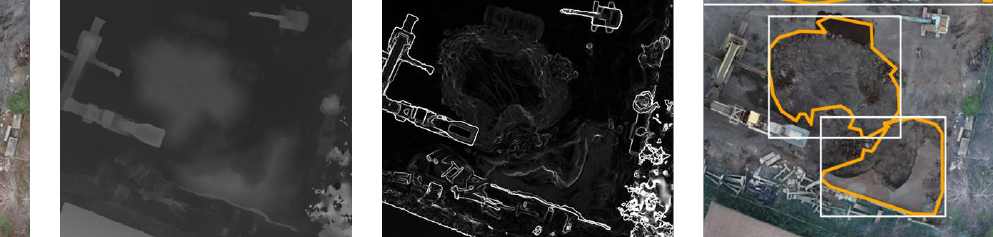
Figure 21. Selected area from test site B as an example for the correct segmentation of individual piles that consist of the same material and border each other.